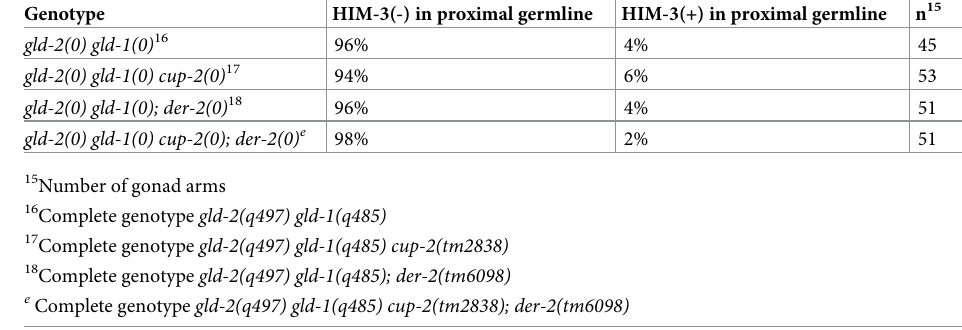
Table 3. Loss of Derlin activity does not supress gld-2 gld-1 Notch-independent tumours. Genotype HIM-3(-) in proximal